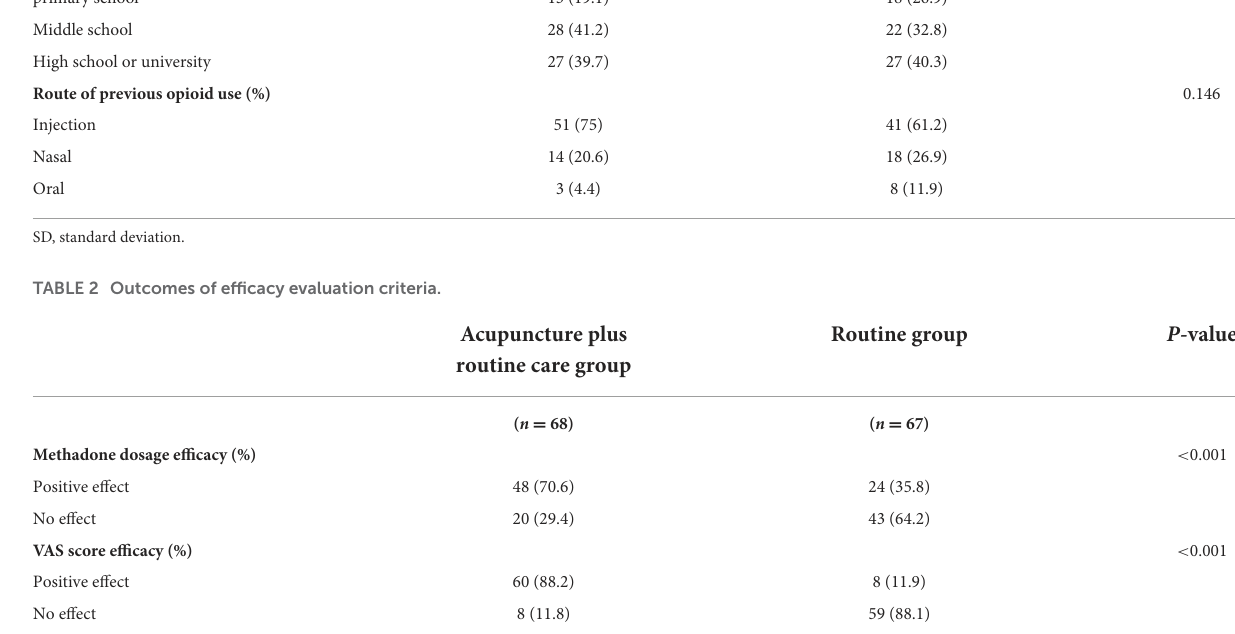
TABLE 2 Outcomes of efficacy evaluation criteria.